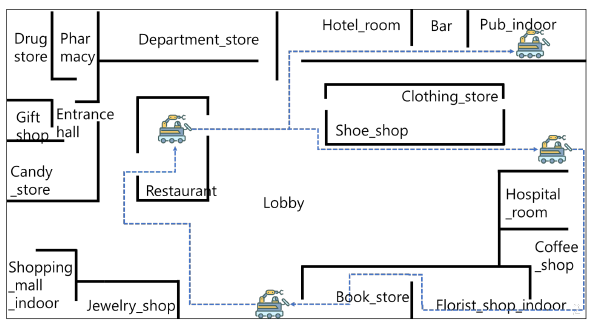
Figure 8. AMR experiment